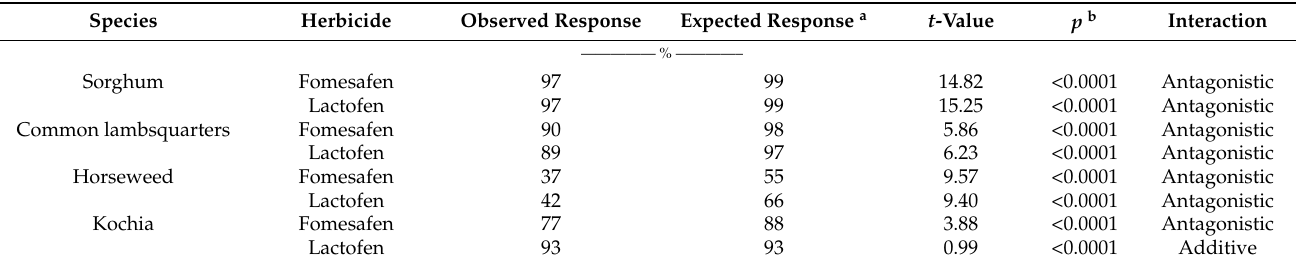
Table 3. Interaction of glyphosate plus fomesafen or lactofen based on dry biomass in glyphosate-susceptible populations of sorghum and common lambsquarters and glyphosate-resistant populations of horseweed and kochia from a greenhouse study conducted in